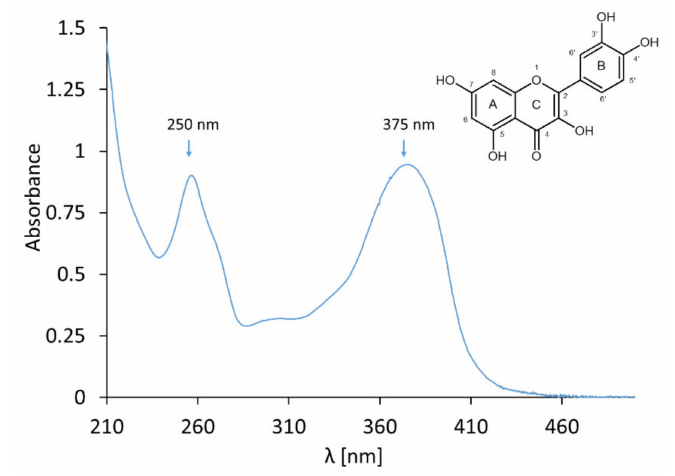
Figure 12. UV-Vis spectra of the ethanolic solution of